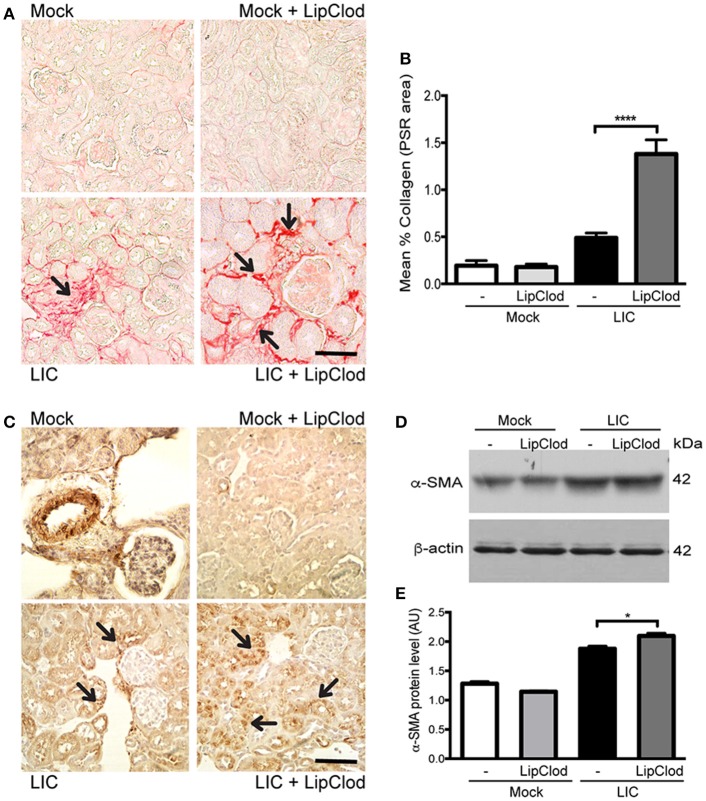
Depletion of macrophages resulted in an increased fibrosis. (A,B) Picrosirius red was used for collagen staining of kidney sections for all groups of mice at 45 dpi and digital quantification of fibrosis revealed significantly increased collagen deposition in the LIC + LipClod group of mice at 45 dpi. (C–E) α-smooth muscle actin protein immunostaining in all groups of mice and representative western blot image of α-smooth muscle actin protein in kidney samples from LIC and LIC + LipClod groups of mice at 45 dpi; β-actin was used as a housekeeping control. Data represent assays of two independent experiments of groups of 6 animals, each. For digital quantification, the samples derive from the same experiment and the gels/blots were processed in parallel. AU, arbitrary units; *P < 0.05; ****P < 0.0001.